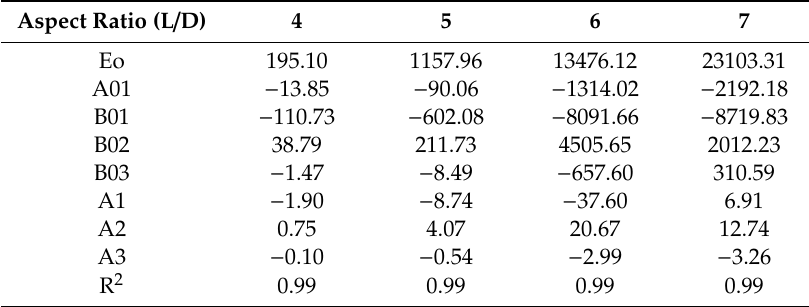
Table 1. Constants for the fitted interaction potential models of AuNRs with a diameter of 2 nm and di ff erent aspect ratios (L /